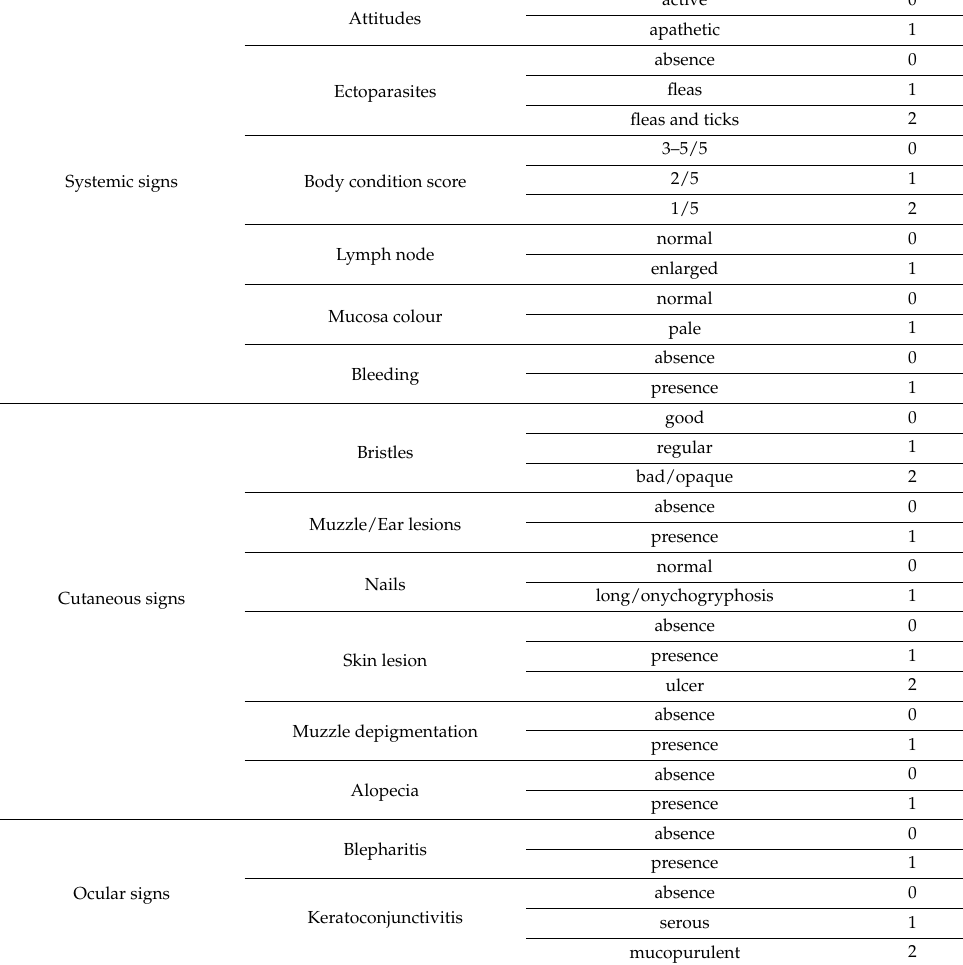
Table 1. Clinical sign-based score for canine leishmaniosis ranging between 0 and 19 (modified from [32]).